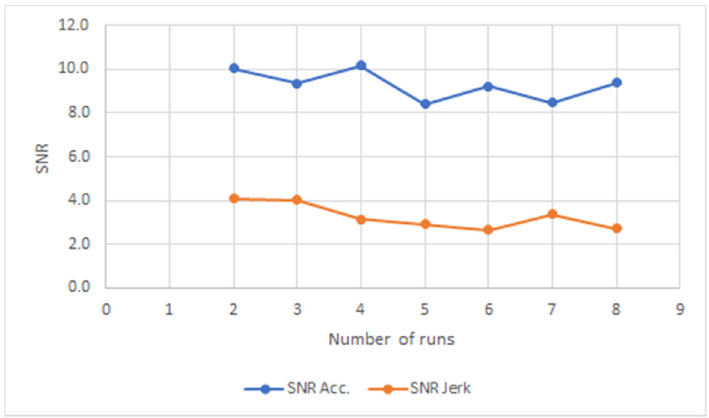
Figure 6. One experienced temporary user.